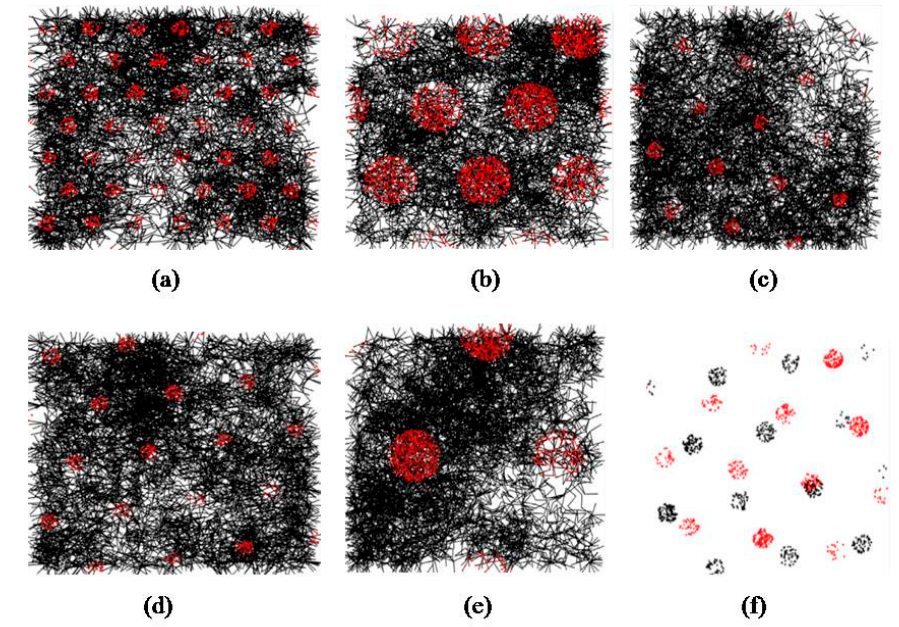
Figure 18. Output grid patterns of the quadrant model: ( a ) grid spacing of 15 units taken with the grid ring radius of 3 units; ( b ) grid spacing of 35 units with the grid ring radius of 10 units; ( c ) spacing of 25 units, radius 3 units and orientation of 30 degrees; ( d ) spacing of 25 units, grid ring radius is of 3 units and orientation of 10 degrees; ( e ) spacing of 55 units, and radius of 10 units; ( f ) Interference of two different grid patterns.